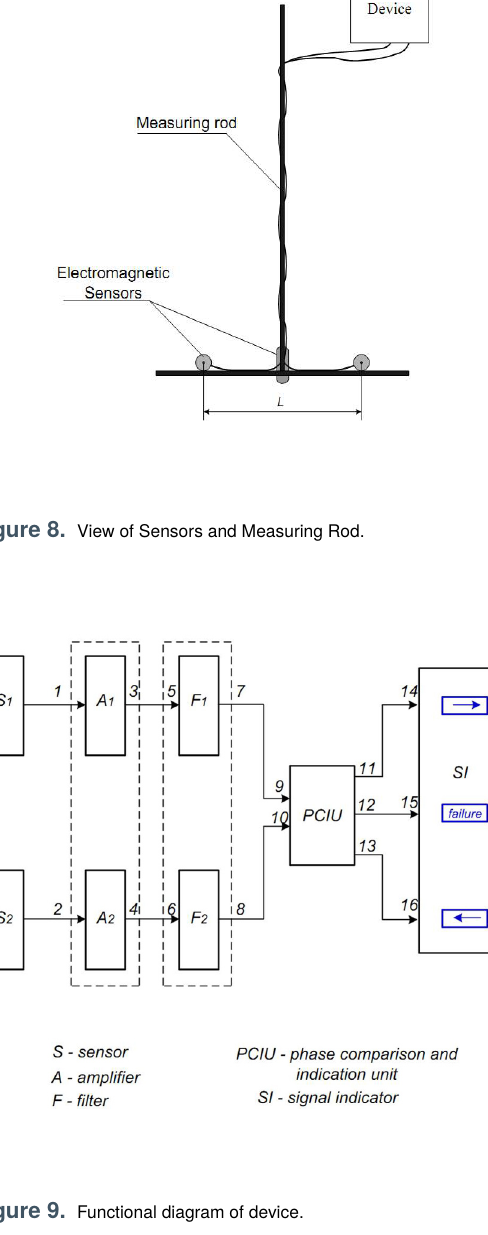
Figure 9. Functional diagram of device.